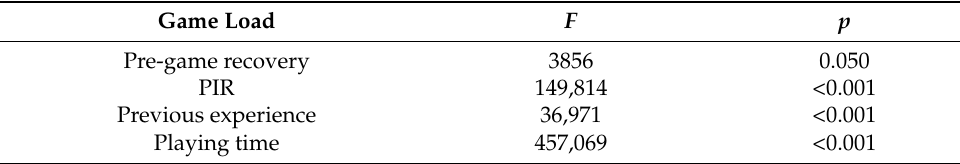
Table 3. Main significant effects on game